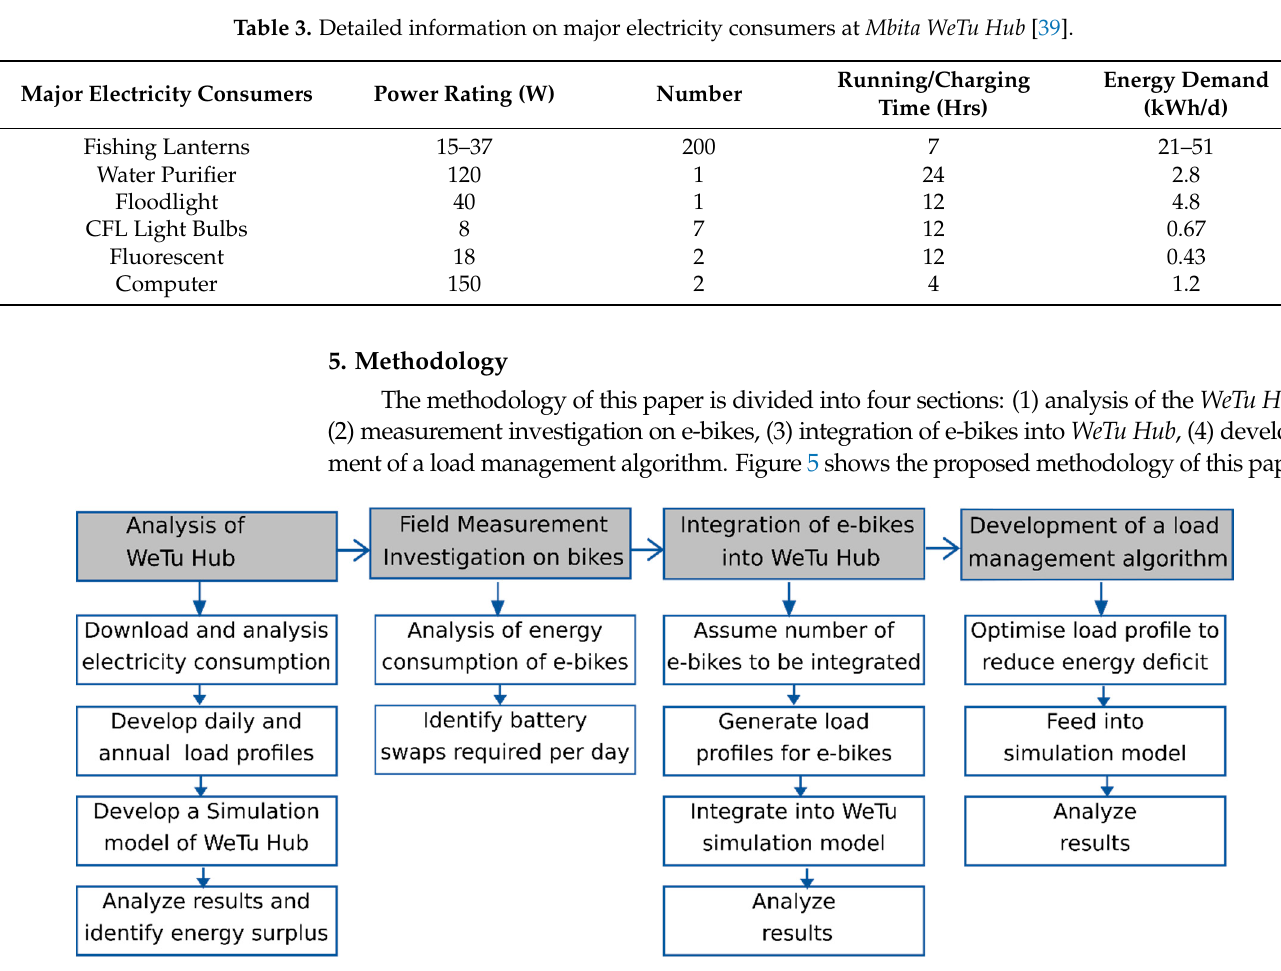
Figure 5. Proposed methodology.